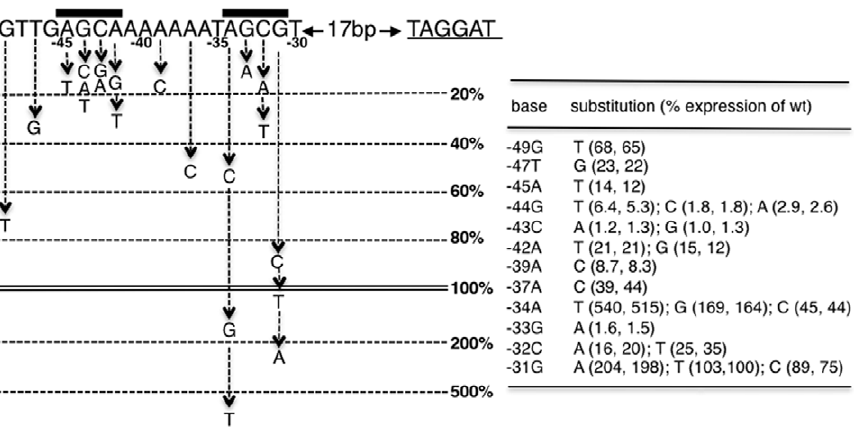
Figure 4. Effect of base substitutions of the trxB promoter on trxB expression. Single base pair substitutions were generated in the trxB promoter ( 2 115 to + 47). The mutated promoters fused to lacZ were introduced in spx mutant strains expressing spx DD from the IPTG-inducible P spank-hy promoter. Expression of trxB-lacZ was determined in at least two independent isolates as described in Fig. 3. The effect of each base substitution is shown as a percentage of the peak trxB transcribed from the wild-type promoter, which was used as a control in each experiment. The peak expression was generally seen around 1.5 hr after the addition of IPTG.